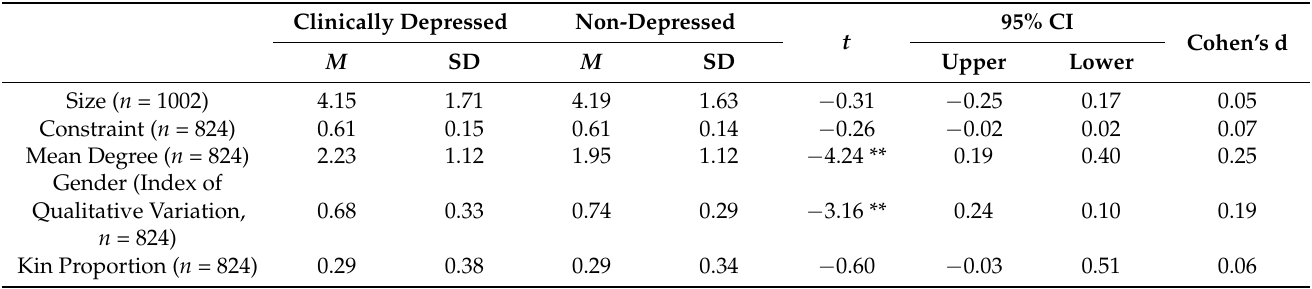
Table 3. Network structures by clinical